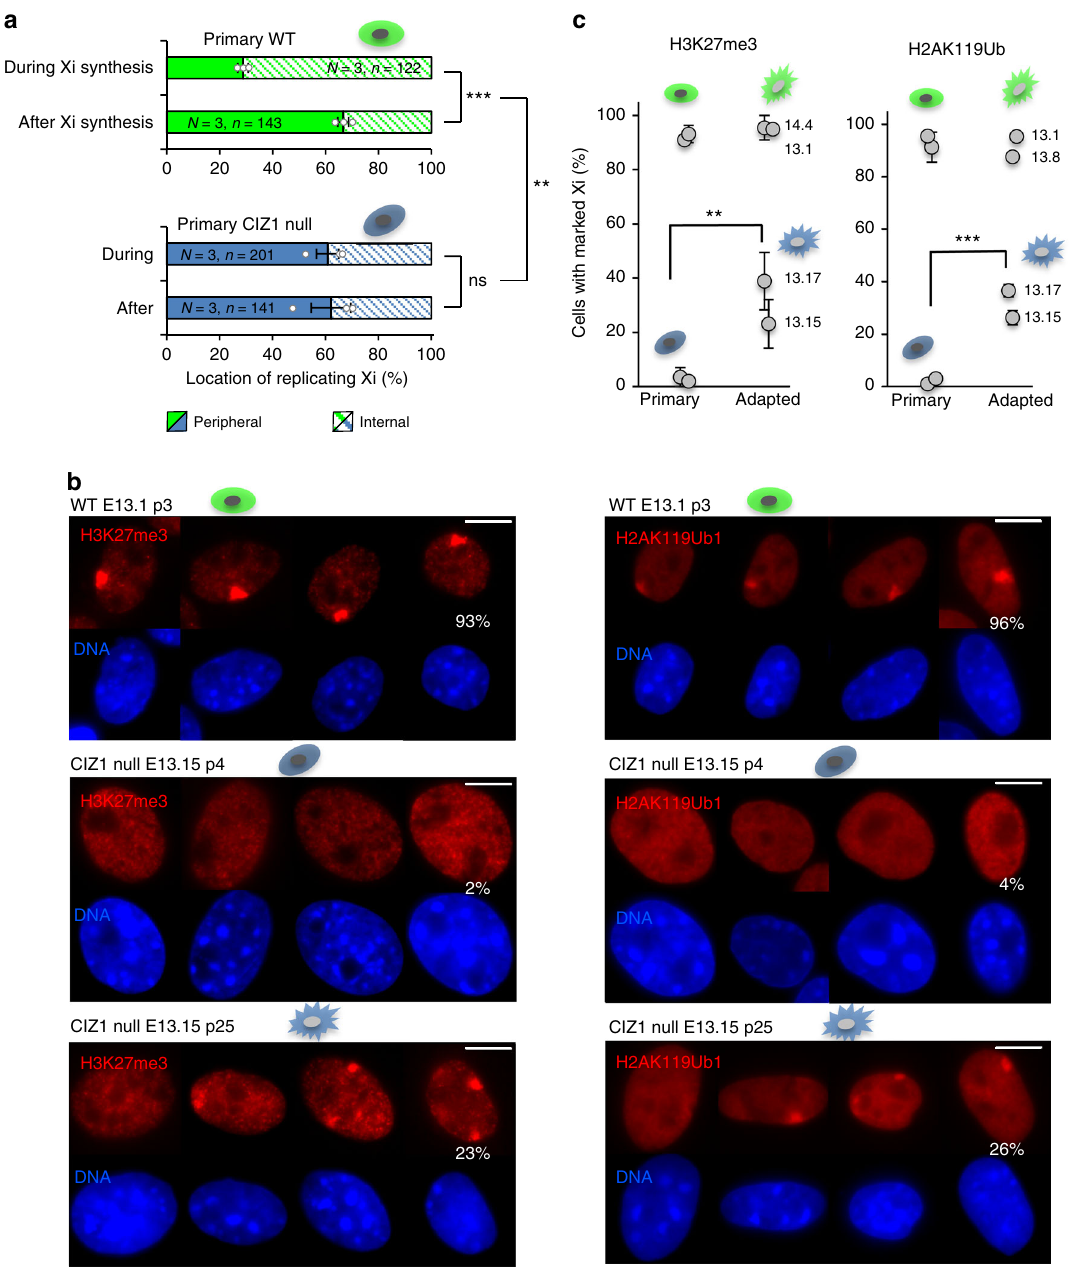
Fig. 4 CIZ1 is required for PRC-mediated chromatin modi fi cation in primary cells. a Binary classi fi cation of Xi location (peripheral or internal) at the time of incorporation of EdU (pulse) or after (chase), analysed by t -test. Graph shows mean data ± SEM for three WT primary embryonic fi broblasts (green, 13.1, 13.8, 14.4 passage 2 – 3) and three CIZ1 null primary embryonic fi broblasts (blue, 13.15, 13.17, 14.2, passage 2 – 3). EdU-Xi in WT cells shifts preferred location during the chase period, but this remains unchanged in CIZ1 null cells, compared by ANOVA. * P ≤ 0.05, ** P ≤ 0.01, *** P ≤ 0.001. N = independent cell lines, n = nuclei scored. Individual data points contributing to the mean are overlaid. b Representative immuno-stain of PRC1-mediated H2AK119Ub1 and PRC2-mediated H3K27me3 in primary WT cells (13.1, p3), absence of these marks in primary CIZ1 null cells (13.15, p4), and re-emergence in culture- adapted CIZ1 null MEFs (13.15, p25). Percentage of cells with marked Xis is shown. Scale bar is 10 microns. c Graphs show the proportion of primary and culture-adapted cells with H3K27me3-marked Xis (left) and H2AK119Ub-marked Xis (right), in CIZ1 null (blue) and WT (green) genotypes, ±SEM from triplicate analyses for each line. Signi fi cant changes upon culture adaptation are indicated, and compared by t